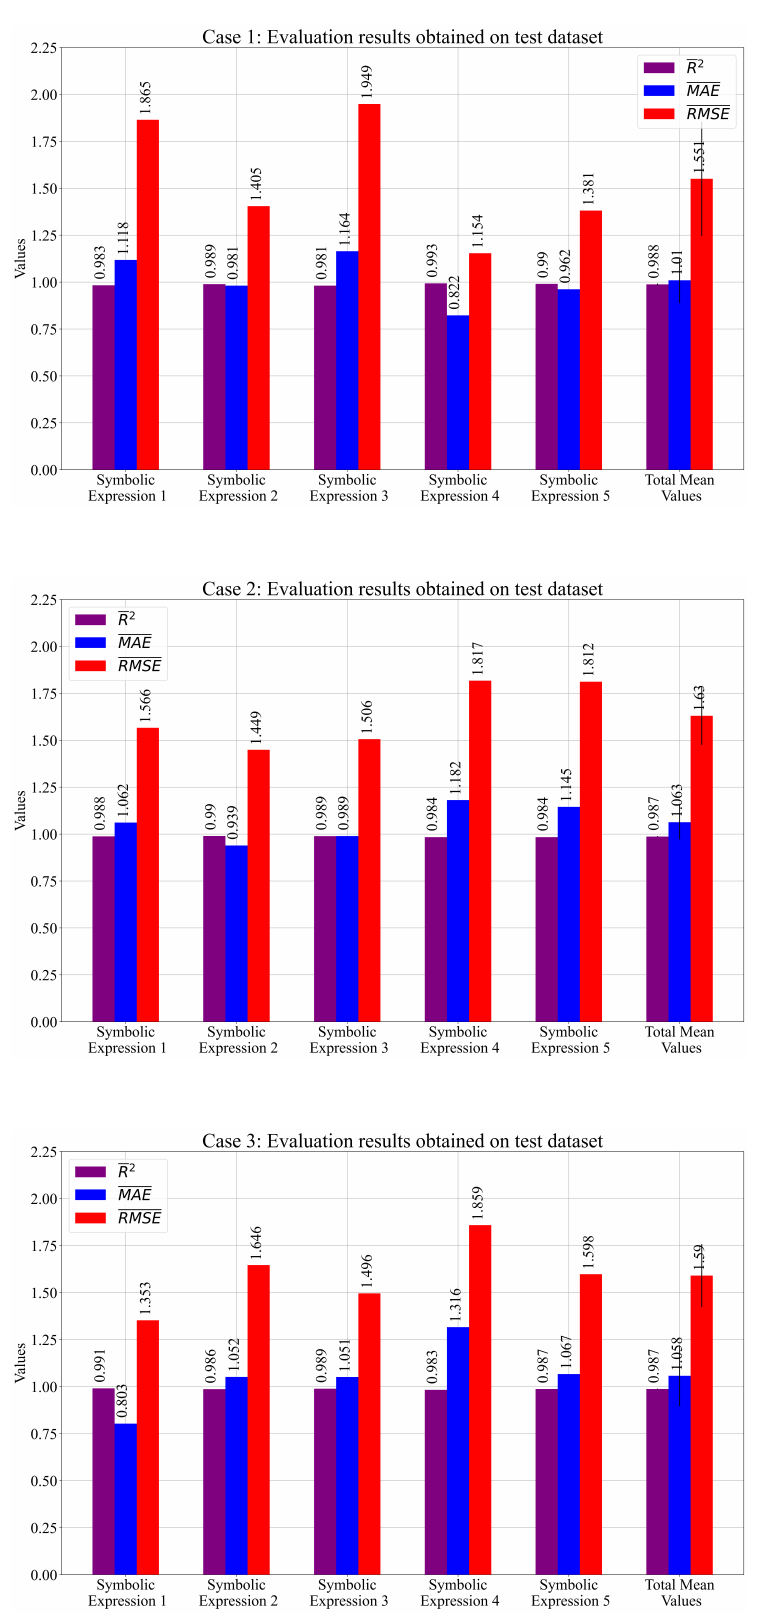
Figure 7. The mean values of the performance metric obtained on the testing dataset. The σ values are presented as error